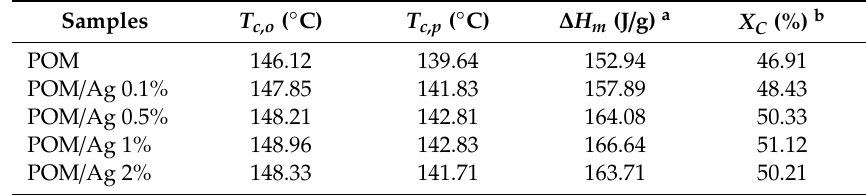
Table 1. Characteristic crystallization peak temperatures. Enthalpy and degree of crystallinity values of samples crystallized with the cooling rate of 10 ◦ C / min.